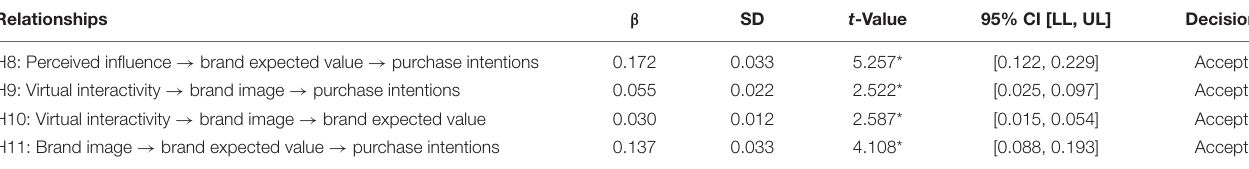
TABLE 6 | Hypotheses testing: indirect relationships. Relationships β